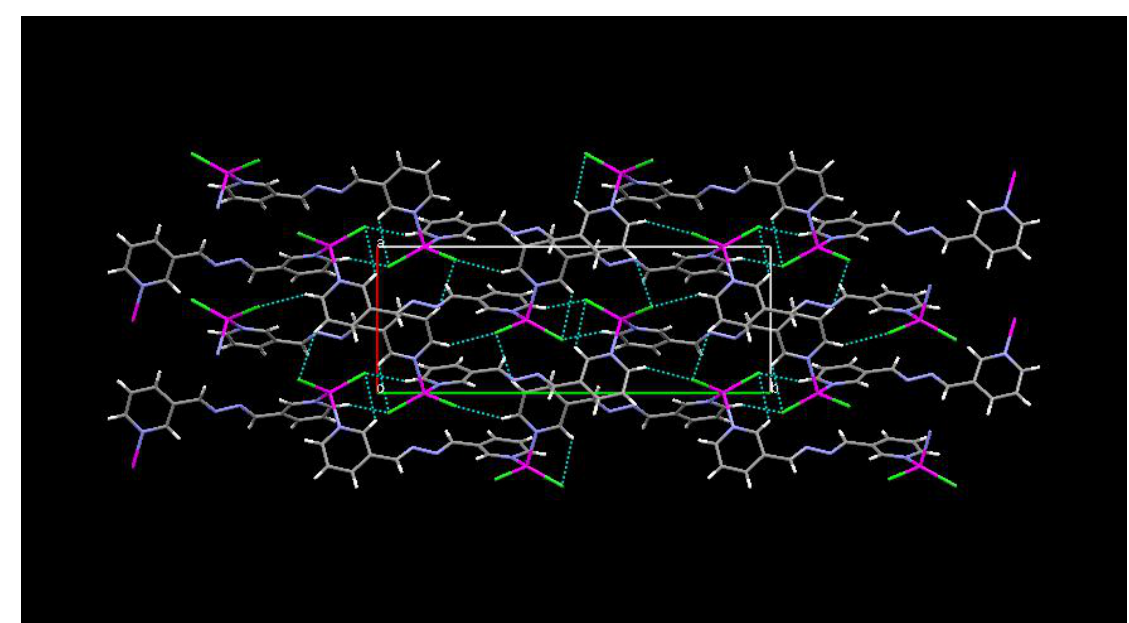
Figure 2. The packing diagram of compound 1 , viewed along the c axis. Dotted lines indicate hydrogen